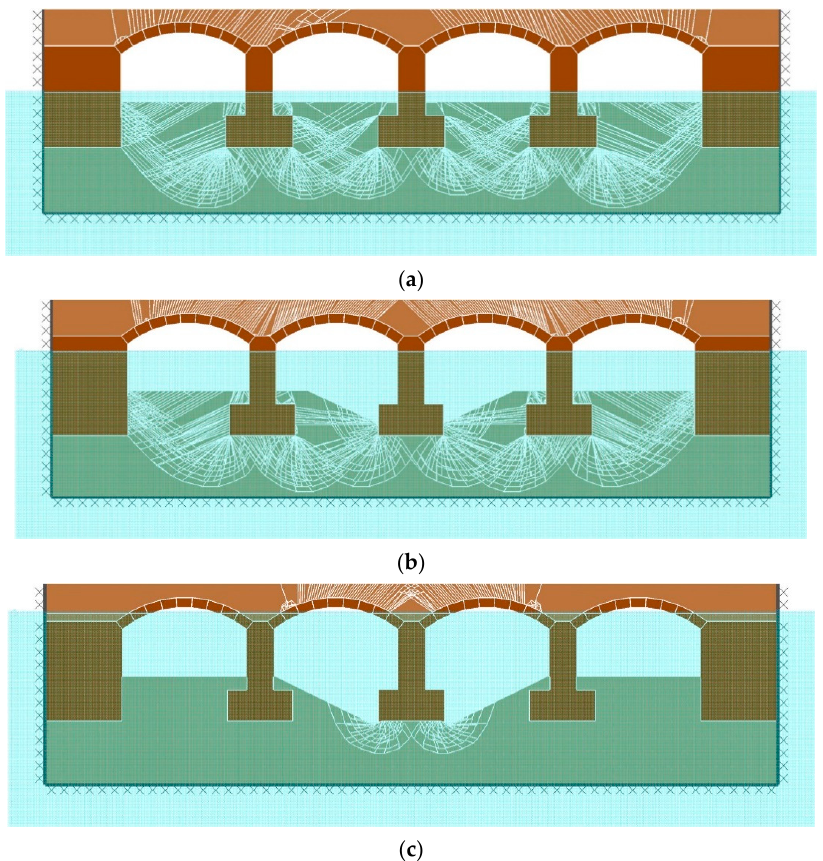
Figure 6. DLO model of the masonry arch bridge in LimitState:GEO [89]: ( a ) no scour condition, ( b ) 1.30 m of scour depth, ( c ) 1.85 m of scour depth.